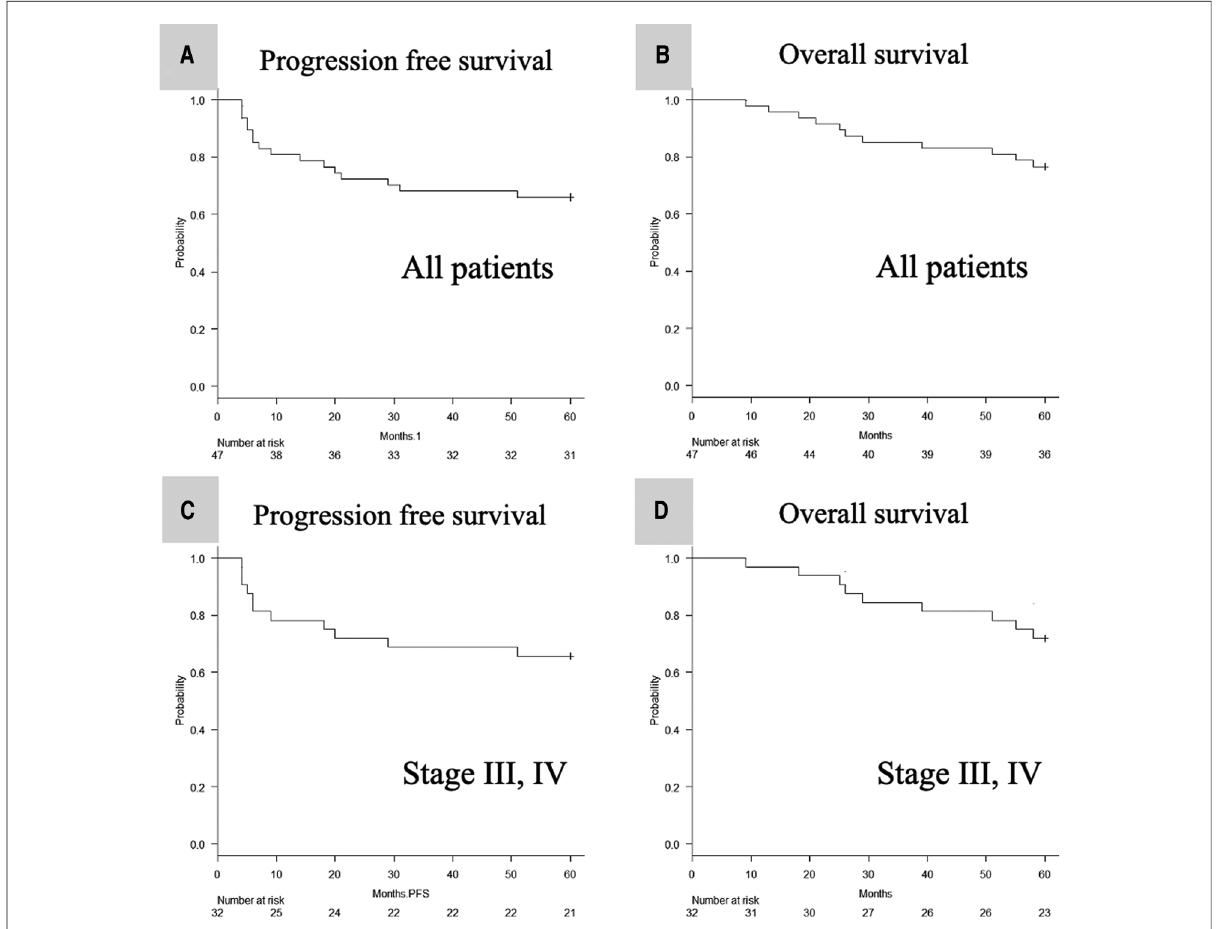
FIGURE 2 Kaplan – meier analysis of the 5-year PFS ( A ) and OS ( B ) of all 47 patients, and the 5-year PFS ( C ) and OS ( D ) of stage III, IV de fi ned by UICC 8th patients. PFS, progression-free survival; OS, overall survival; UICC, Union for International Cancer